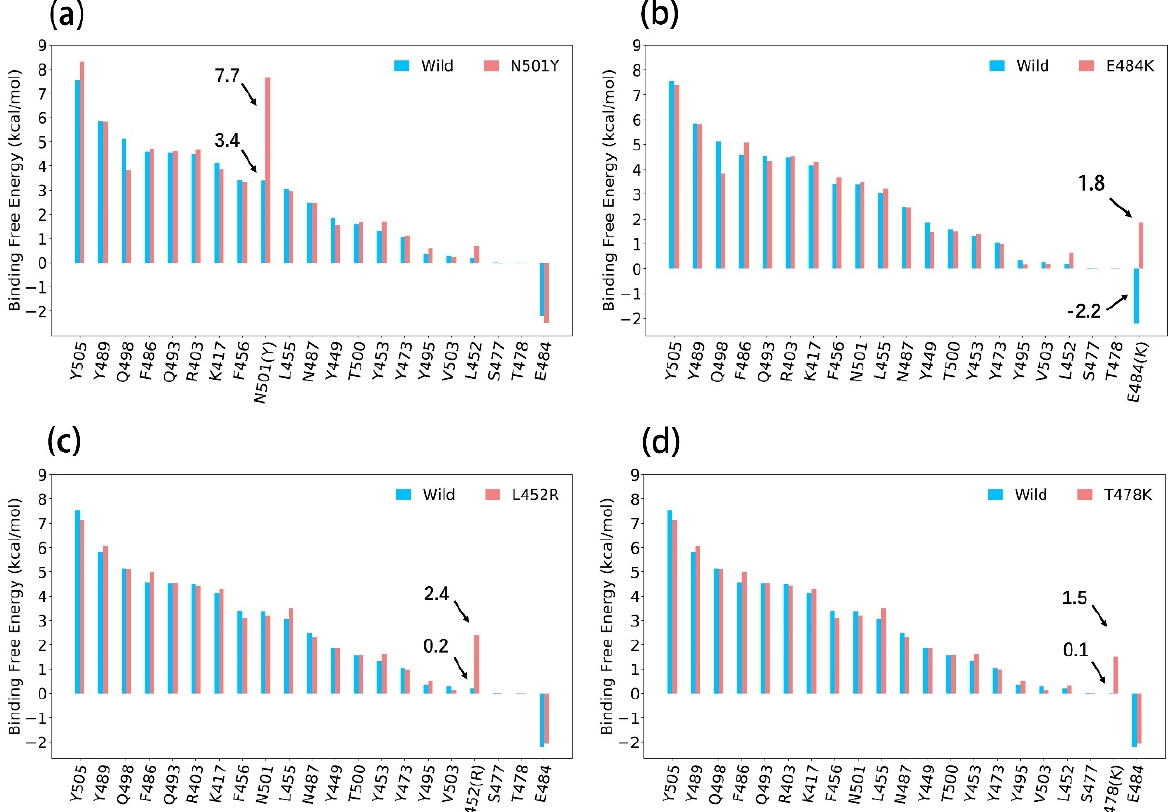
Figure 1. Residue-specific binding free energy data of the S protein between the wild type and the different mutants in binding to ACE2 from the ASGB calculation. (Calculated results were averaged over 5 trajectories separately). The ( a – e ) show the specific binding affinity contributions of interface residues on S protein for wild type and N501Y, E484K, L452R, T478K and K417N complex. 3.1.1. N501Y The N501Y mutation exists in Alpha, Beta and Gamma variants. As shown in Figure 1a, the binding contribution of N501Y residue (7.7 kcal/mol) is significantly higher than N501 (3.4 kcal/mol). In Table 2, the computational ΔΔ G of N501Y is 4.3 kcal/mol, in which the van der Waals interaction contributed to 3.8 kcal/mol and that is the main reason for the large binding free energy calculated. According to the local structure in Figure 2, a π – π interaction was formed between ACE2 residue Y41 and N501Y but not with N501. We consider that the π – π interaction between Y501 and Y41 is the main reason of the en- hanced binding affinity. Although the calculated value is larger than the experimental data, we believe that such overestimation is related to the overestimation of the van der Waals interaction energy.